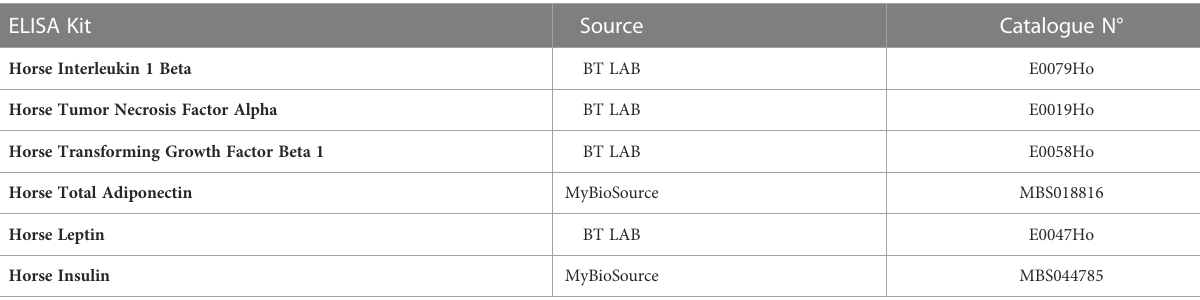
TABLE 1 List of used ELISA assays